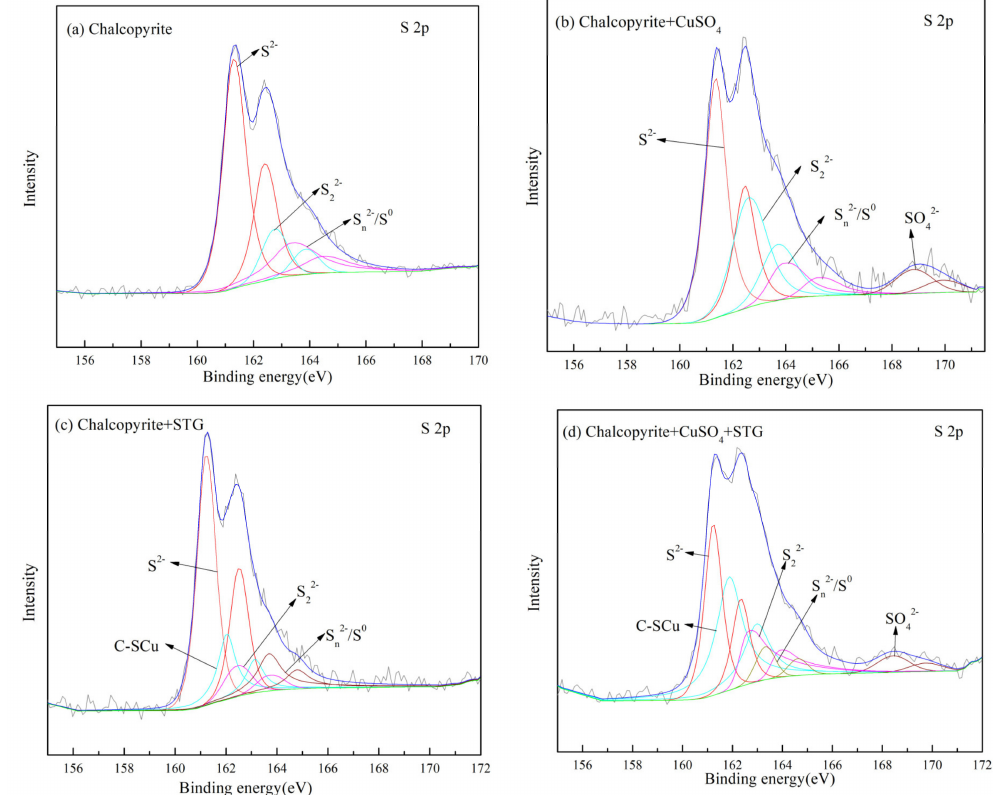
Figure 6. S 2p XPS spectra of chalcopyrite ( a ), chalcopyrite + CuSO 4 ( b ), chalcopyrite + STG ( c ) and chalcopyrite + CuSO 4 + STG ( d ); c(CuSO 4 ) = 1 × 10 − 3 mol / L, c(STG) = 1.5 × 10 − 3 mol /